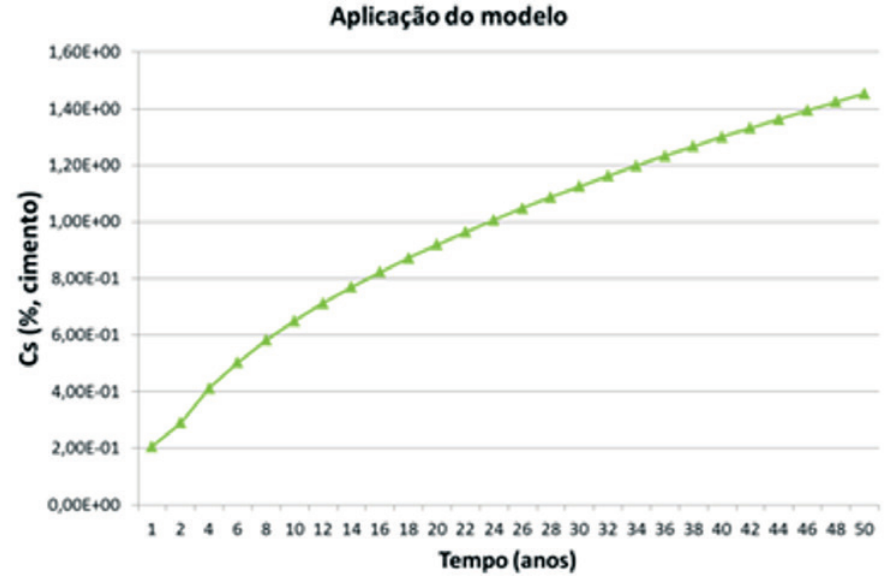
Concentração superficial adotada (zona de atmosfera